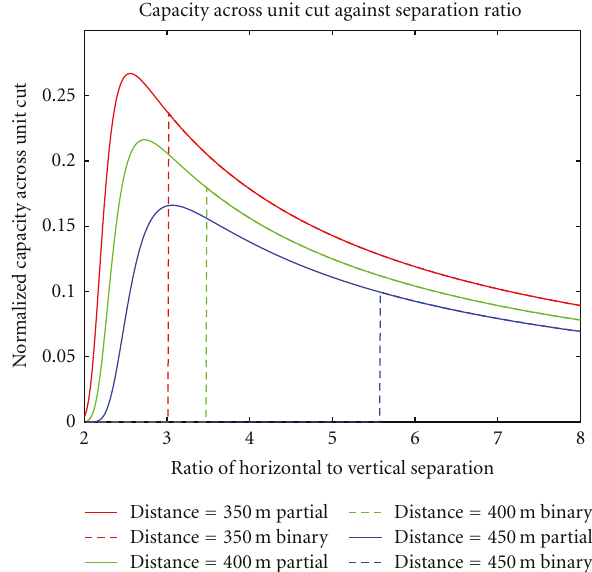
Figure 3: Capacity across unit cut for di ff erent lengths of links under the physical model (binary interference) and partial interfer- ence.